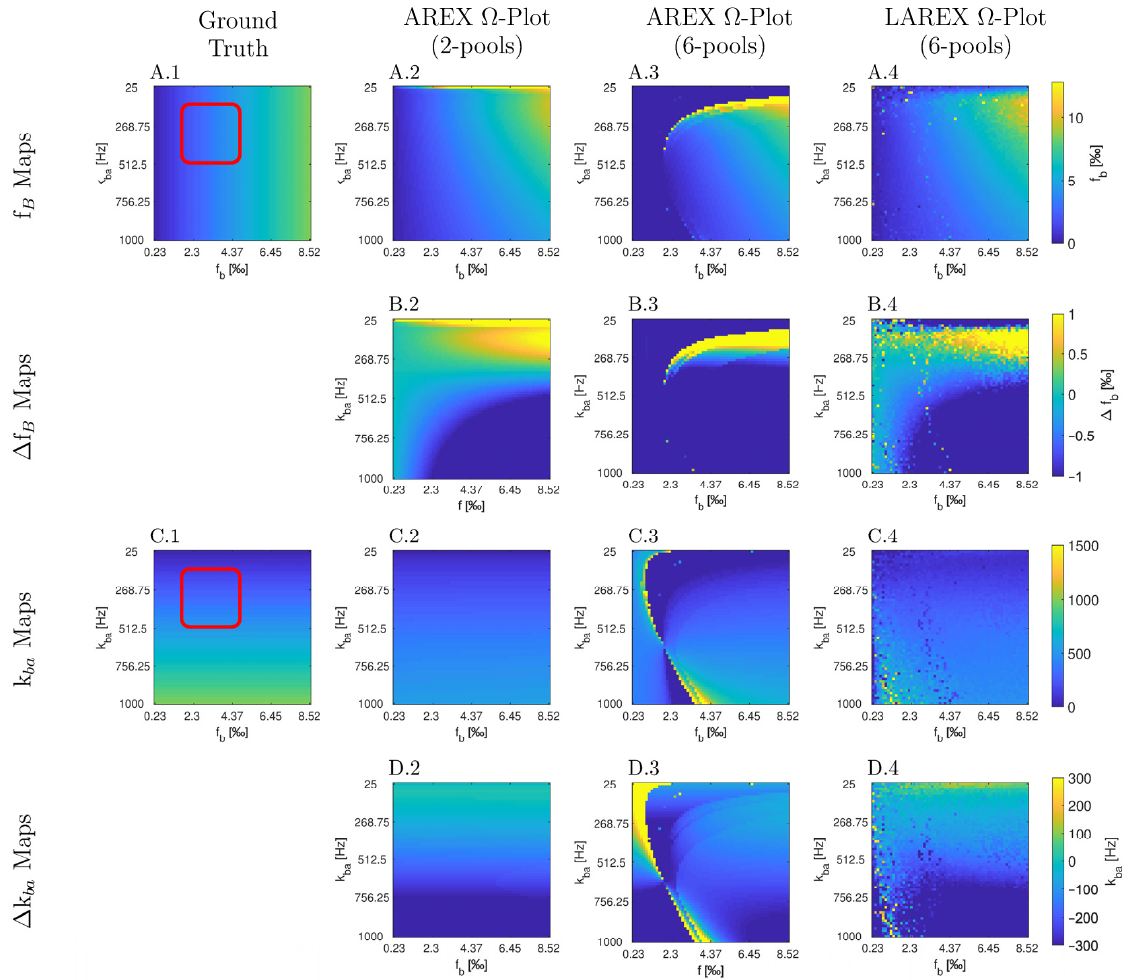
Figure 1. Parameter maps ( A , C ) and color-coded error maps ( B , D ) for fractional Glycosaminoglycan (GAG) concentrations f b and exchange rates k ba , as a function of f b and k ba , determined by apparent exchange-dependent relaxation (AREX) Ω -plots on two- and six-pool systems, LAREX Ω -plots on a six pool system, as well as the ground truth maps with a red box with marked the clinically relevant rates and relaxation times of human IVDs at 3 Tesla observed in previous studies [8,25,28], and